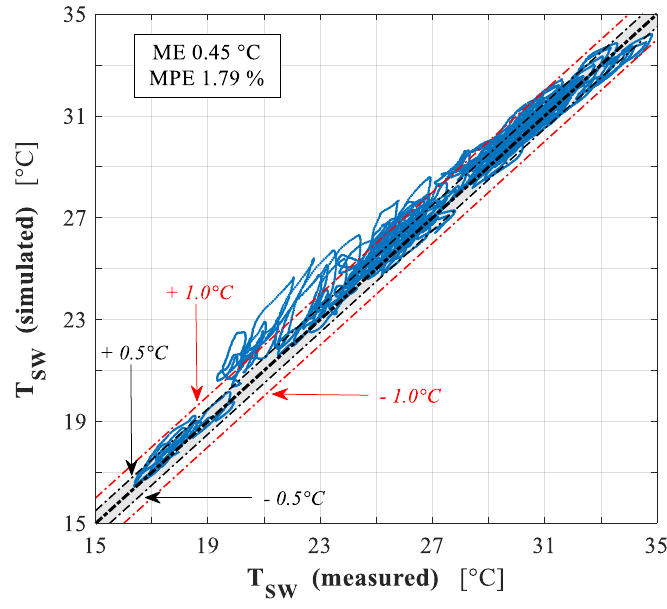
Figure 21. South-West wall temperature: simulated vs. experimental results (from February to November).